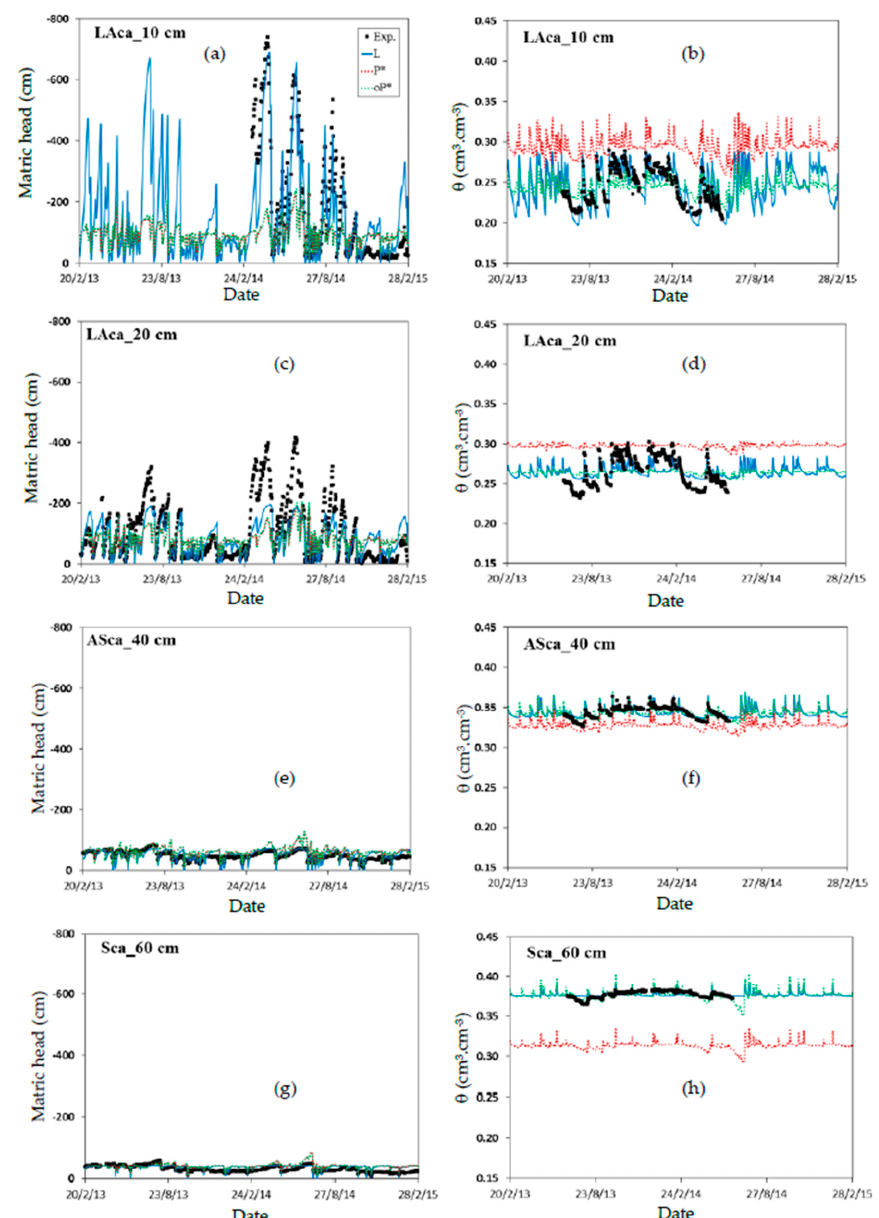
Figure 6. Comparison of experimental and simulated matric head and volumetric water content data at the 10 (( a ); ( b )), 20 (( c ); ( d )), 40 (( e ); ( f )) and 60 (( g ); ( h )) cm depths on Lys. 1. L for results obtained with the parameters optimized with HYDRUS-1D on lysimeter data; P* for results obtained by applying the mean optimized parameters from the 165 cm deep profile of the three field plots; oP*, the same as P* but for saturated water content values ( θ s , θ s * ) again optimized for each soil